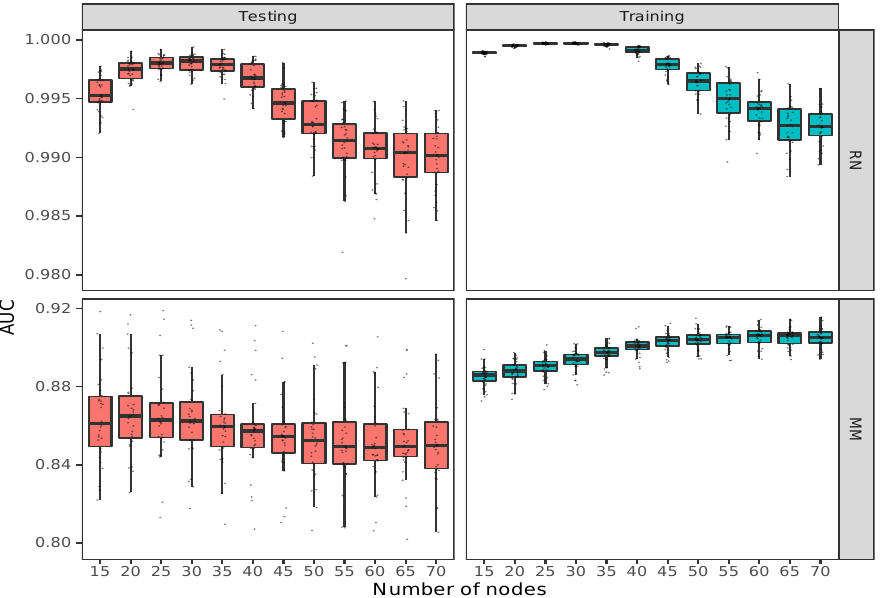
Figure 5. Box plots of 30 AUCs of LLA algorithm with nodes being set to J = 15,20, · · · ,70 for training and testing data. The top panel is the AUCs of RN data set, and the bottom panel is the AUCs of MM data